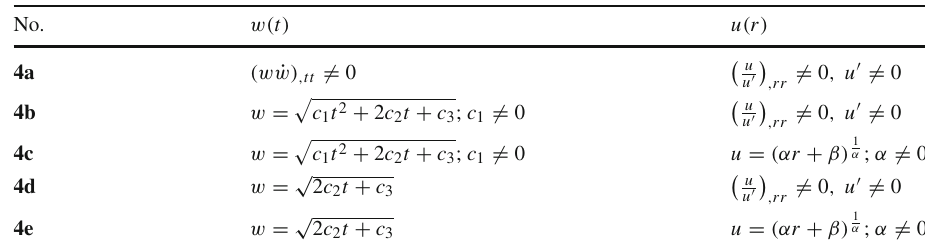
Table 1 Metrics admitting four